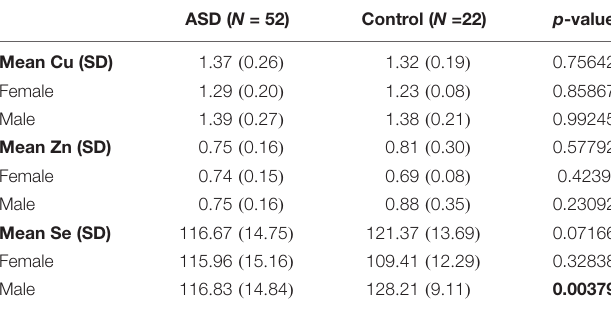
TABLE 3 | Median Cu, Zn, and Se levels for cases and controls, stratified by